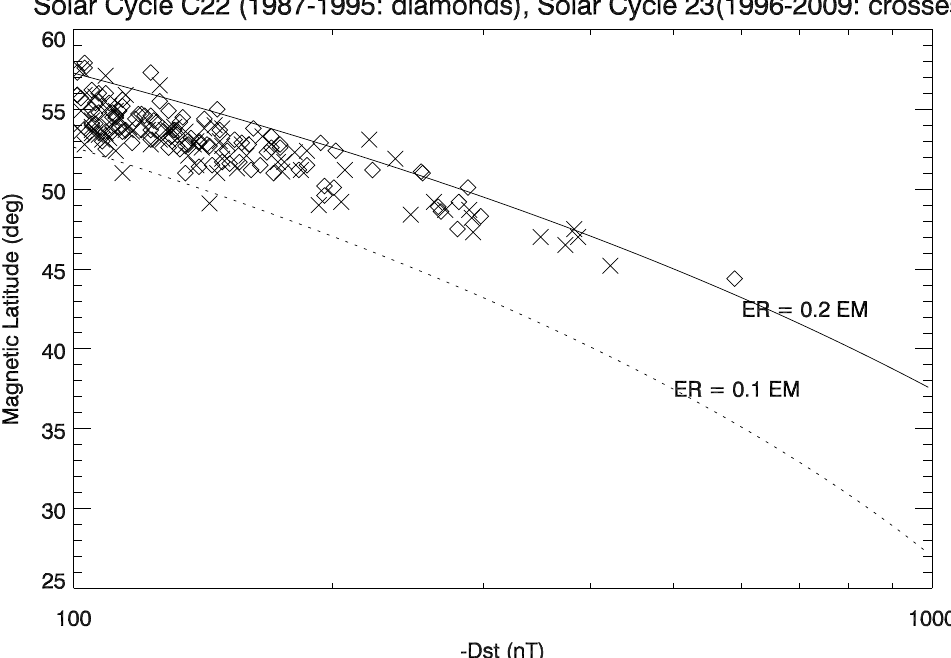
Fig. 4. Minimum magnetic latitude of the auroral equatorial boundary against the peak intensity of magnetic storms. Diamonds and crosses show the scatter plots for solar cycle 22 (1987 – 1995) and solar cycle 23 (1996 – 2009), respectively. Dotted and solid lines show the 10% and 20% ef fi ciency to transform ER from EM, respectively.